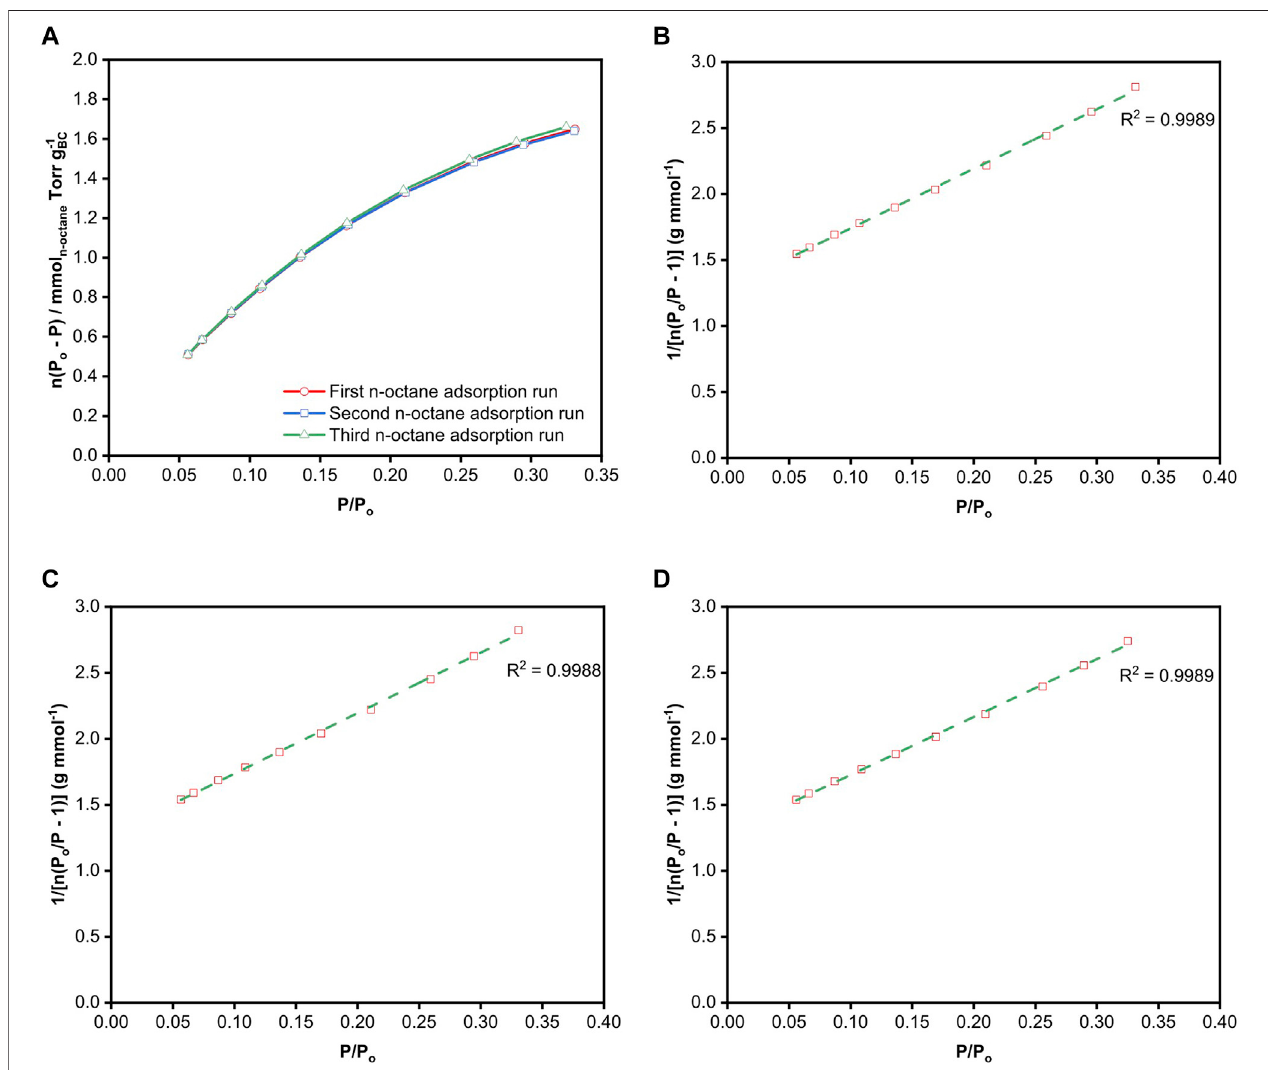
FIGURE 6 | (A) n ( P o − P ) vs P / P o plot of n-octane adsorption on freeze-dried BC determined using iGC, which shows that the range 0.05 ≤ P / P o ≤ 0.35 can be used for BET analysis. BET plots of freeze-dried BC obtained from the (B) fi rst, (C) second and (D) third n-octane adsorption runs, fi tted over the range of 0.05 ≤ P / P o ≤